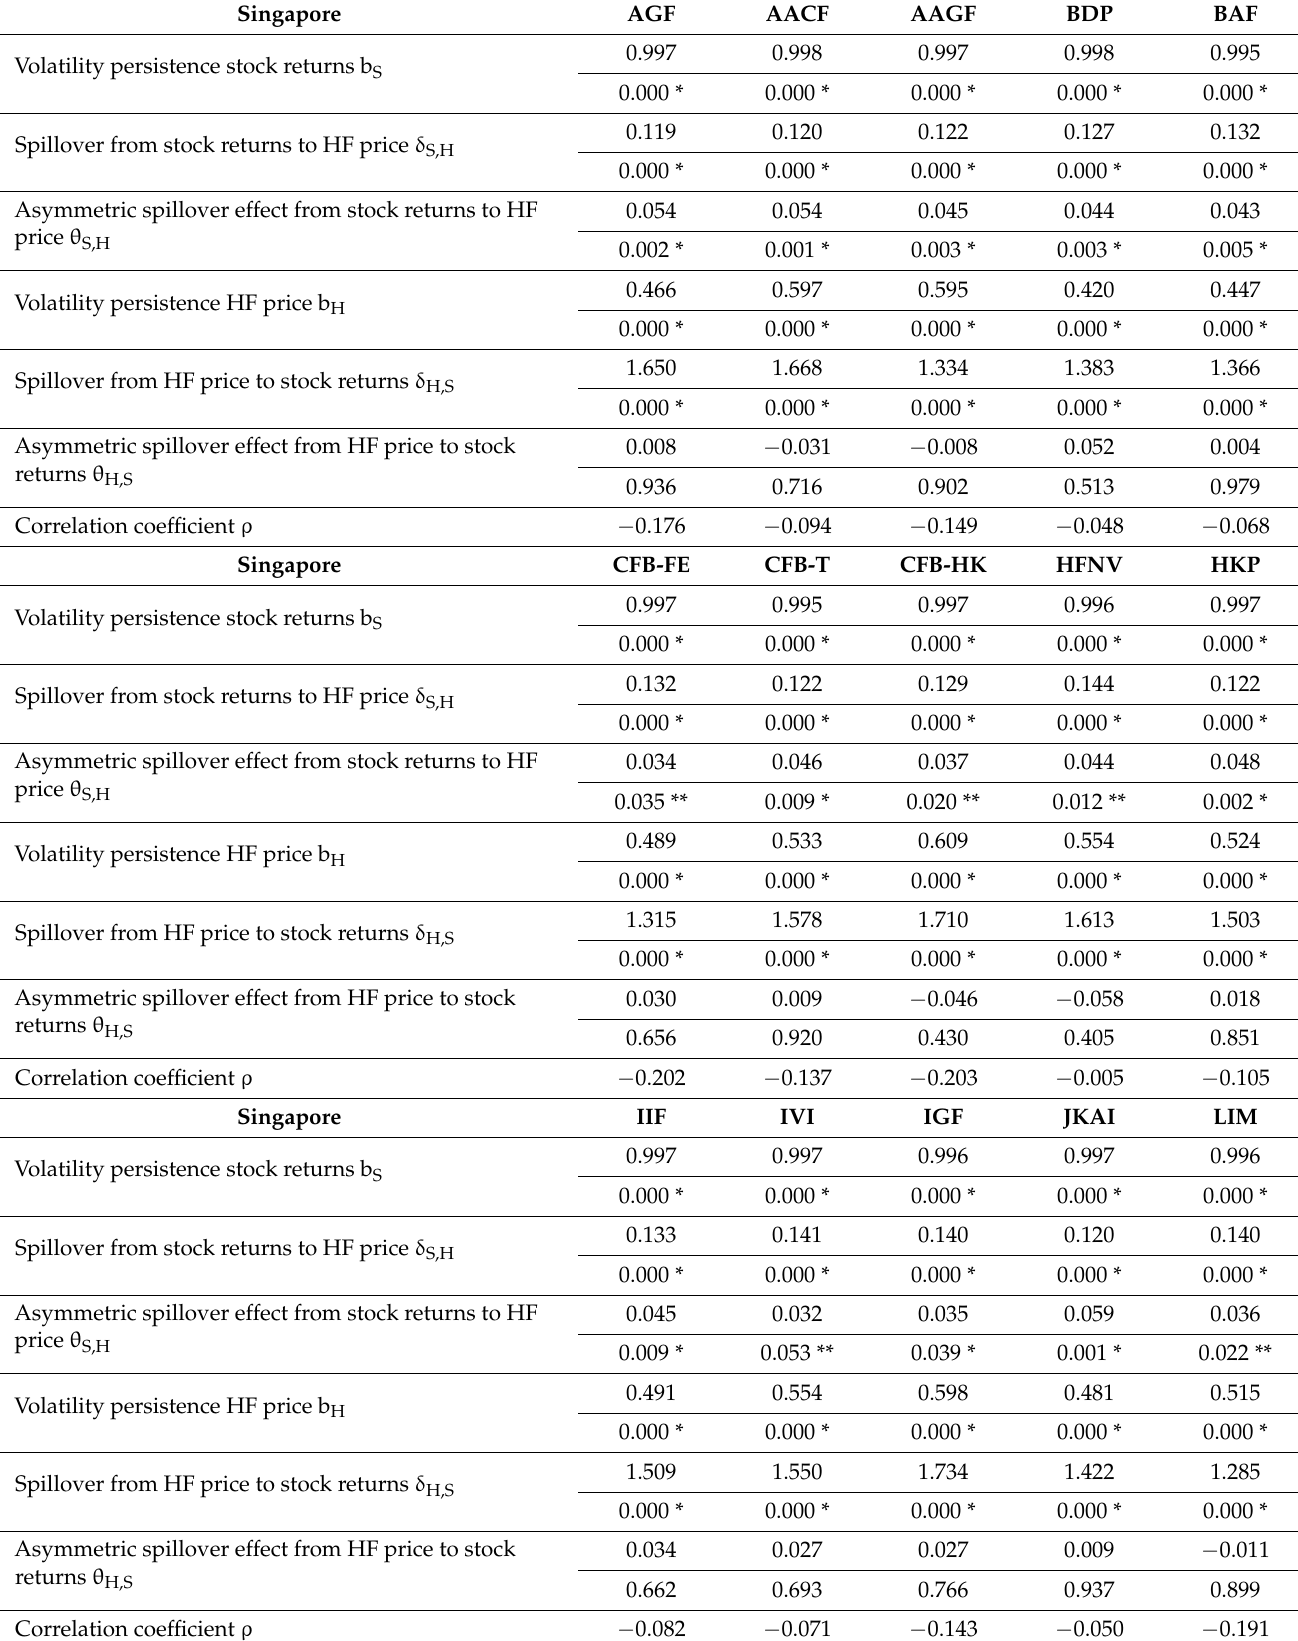
Table 5. The Volatility spillover between the Singapore Stock Market (STI) and Hedge Fund